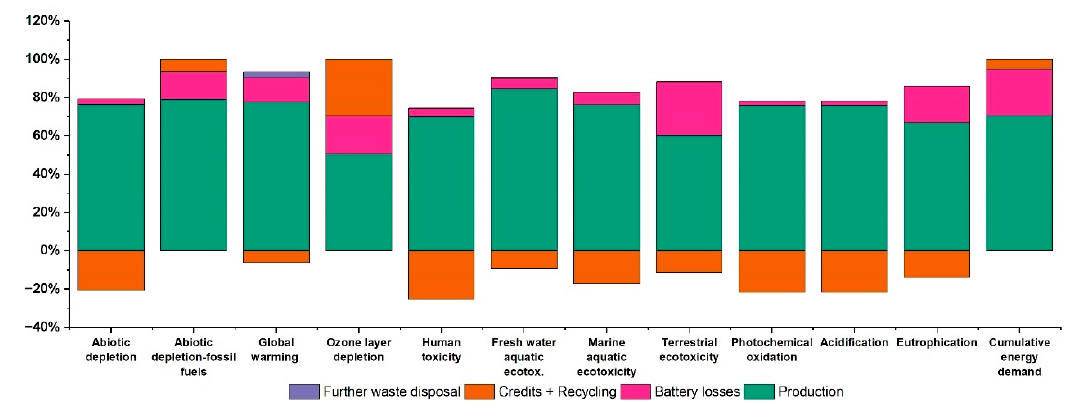
Figure 4. Cradle-to-grave life cycle assessment of the NMC111 battery.